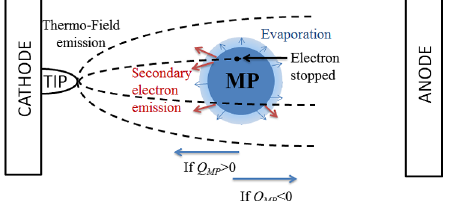
FIG. 2. Representation of the three characteristic zones of a specific electric field, as used in this model. Zone I: field enhancement close to the emissive tip extending on twice the tip height (on the figure is indicated the larger value of this zone for a tip of 10 μ m height and 0 . 97 μ m radius at its base); zone II: zone of uniform field (gap lying from 0.5 to 5 mm); zone III: spherical field produced by the charge of the MP surrounding it. The figure is not drawn to